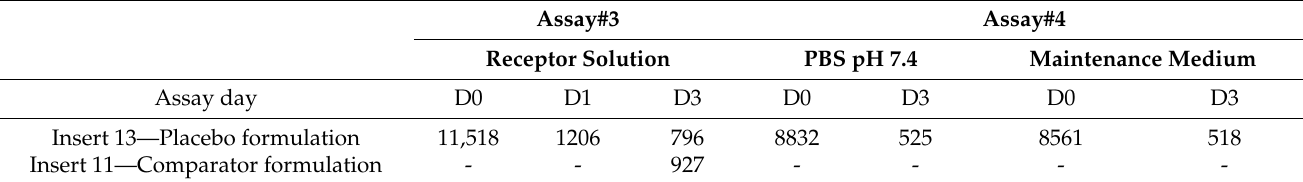
Table 3. TEER ( Ω cm 2 ) measurements performed on the day of reception of the tissues (D0), the day of sample application (D1), and 48 h after sample application (D3) for assay#3 and assay#4 using receptor solution, PBS pH 7.4 or maintenance medium at the top and at the bottom of the inserts to perform the measurements. Assay#3 Assay#4 Receptor Solution PBS pH 7.4 Maintenance